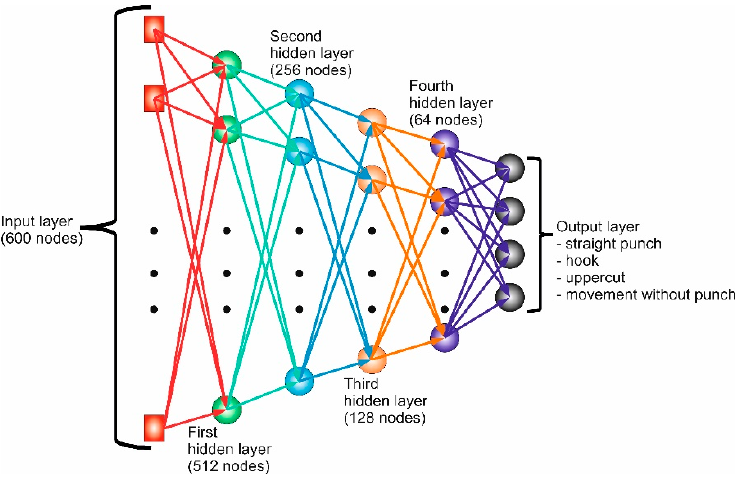
Figure 4. The topology of the artificial neural network (ANN).